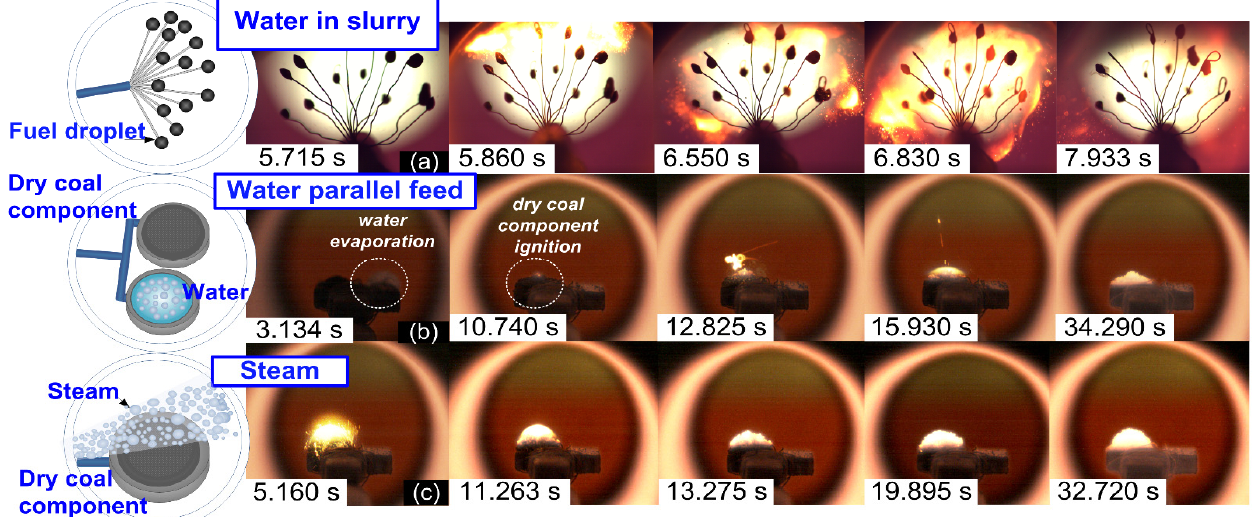
Figure 2. Video frames demonstrating the combustion of fuels based on coal slime at a combustion chamber temperature of 900 ° С (( a )—water in the slurry composition; ( b )—parallel introduction of components; ( c )—water supplied as steam).